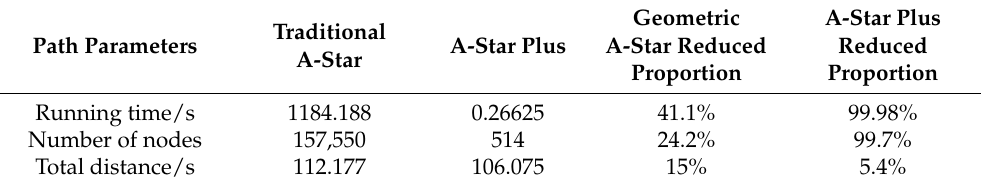
Table 3. Comparison of A-star Plus algorithm with geometric A-star algorithm and traditional A-star